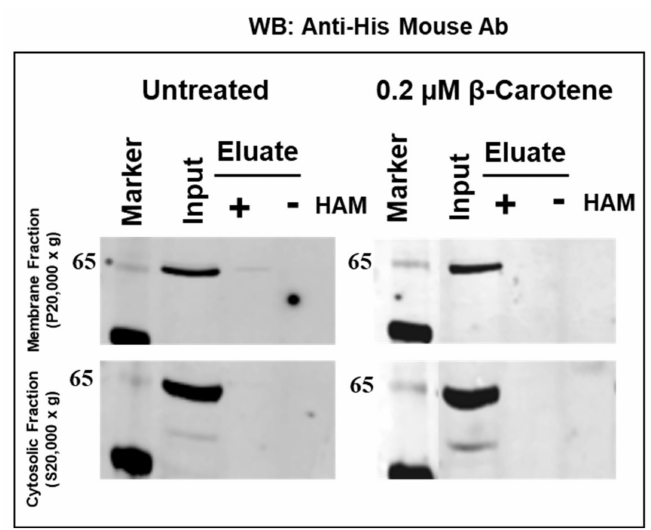
Figure 8. Analysis of palmitoylation of BCOLg in membrane (top panel) and cytosolic fraction (bottom panel) from HEK293F-expressed lysates treated with β -carotene as described in Materials and Methods. The presence of lancelet BCOLg was probed by immunoblotting with Anti-His Mouse monoclonal Roche antibody BMG-His-1 (1:1000) overnight at 4 ◦ C.